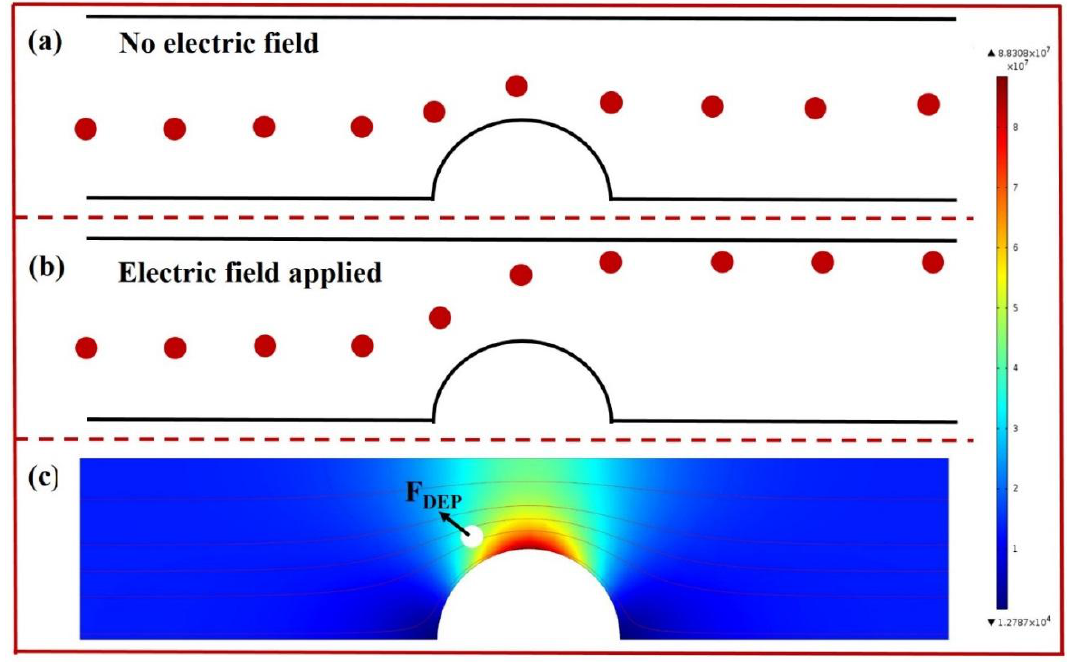
Figure 3. ( a ) Illustration of particles’ trajectory when they travel through a channel neck; ( b ) Comparison of particles’ trajectory when they travel through a channel neck and electric field applied; ( c ) Numerically simulated electric field distribution (E 2 ) around the channel neck. Particles will experience large DEP force at the channel